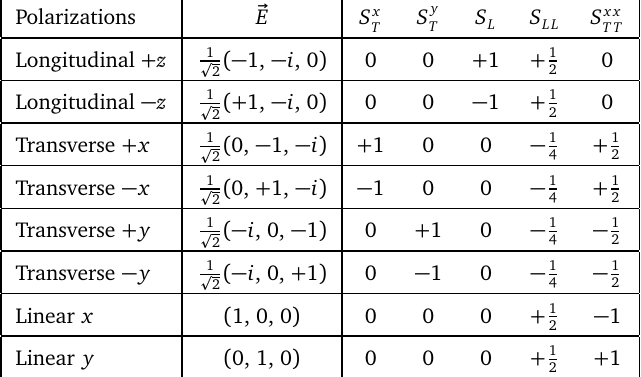
Table 1: Longitudinal, transverse, and linear polarizations of the deuteron, polar- ization vectors, and parameters of spin vector and tensor [ 11, 12, 17 ] . The other parameters vanish in the considered polarizations ( S x y gluon transversity distribution is associated with the polarization parameter S xx